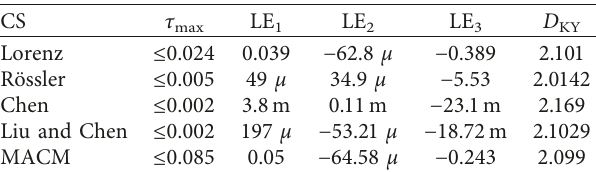
Table 3: Analysis of chaos degradation for DV of 3D CSs by using the NA of Euler (6).